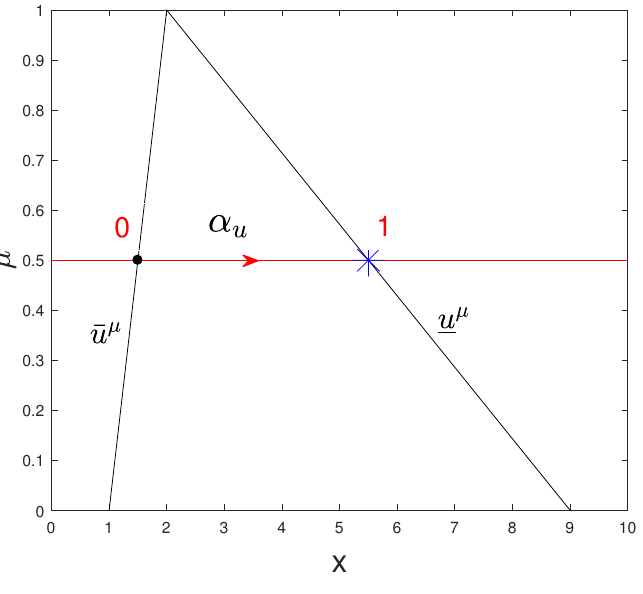
Figure 1. The fuzzy number (cid:101) u = ( 1,2,9 )